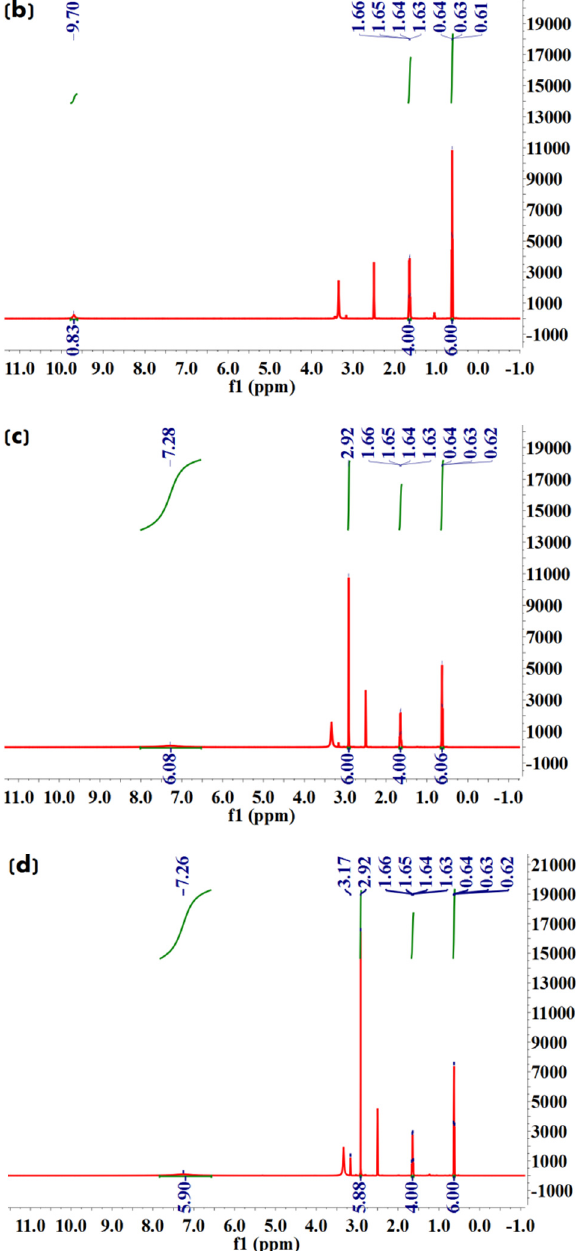
Figure 8 . 1 H NMR spectra of Met·HCl ( a ), Bar·Na ( b ), multicomponent crystal of Met–Bar ( c ), and Figure 8. 1 H NMR spectra of Met · HCl ( a ), Bar · Na ( b ), multicomponent crystal of Met–Bar ( c ), and the solvate crystal ( d ). the solvate crystal ( d